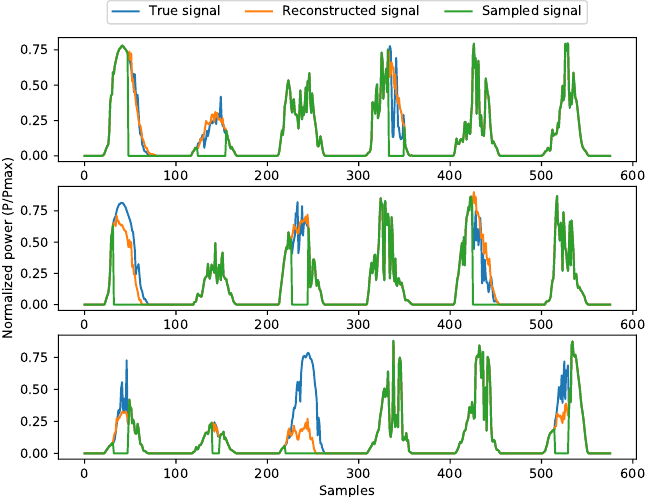
Figure 7. Reconstruction example of a corrupted signal with gaps of expected length of 8 h per day. Visualization for three nodes in a window of six days. The signals are normalized by the peak